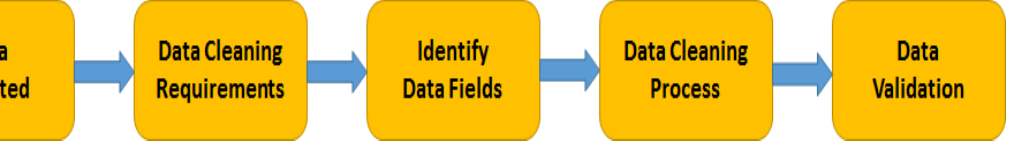
Figure 2. Data Cleaning